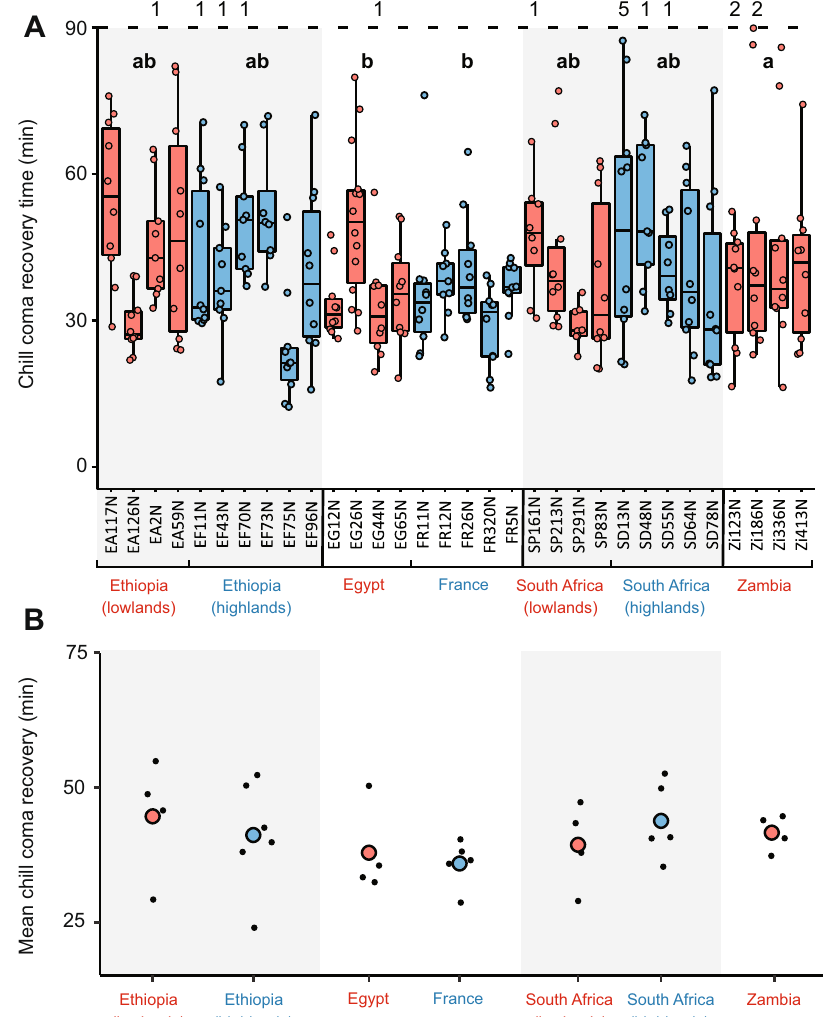
Figure 3. Chill coma recovery times of D. melanogaster females of all lines used. (A) All data shown. Lines in blue are from relatively cold habitats, whereas lines in red are from relatively warm habitats. The thicker line in the centre of each boxplot represents the median, and the upper and lower hinges represent first and third quartiles, respectively. Whiskers extend to 1.5 times the interquartile range, or to the smallest or largest values if they fall within 1.5 * IQR. Coloured circles represent individual flies. Populations that share a letter do not significantly differ at the population level (p < 0.05). (B) Mean CCRT of each line (black circles) and overall mean of all lines from each population